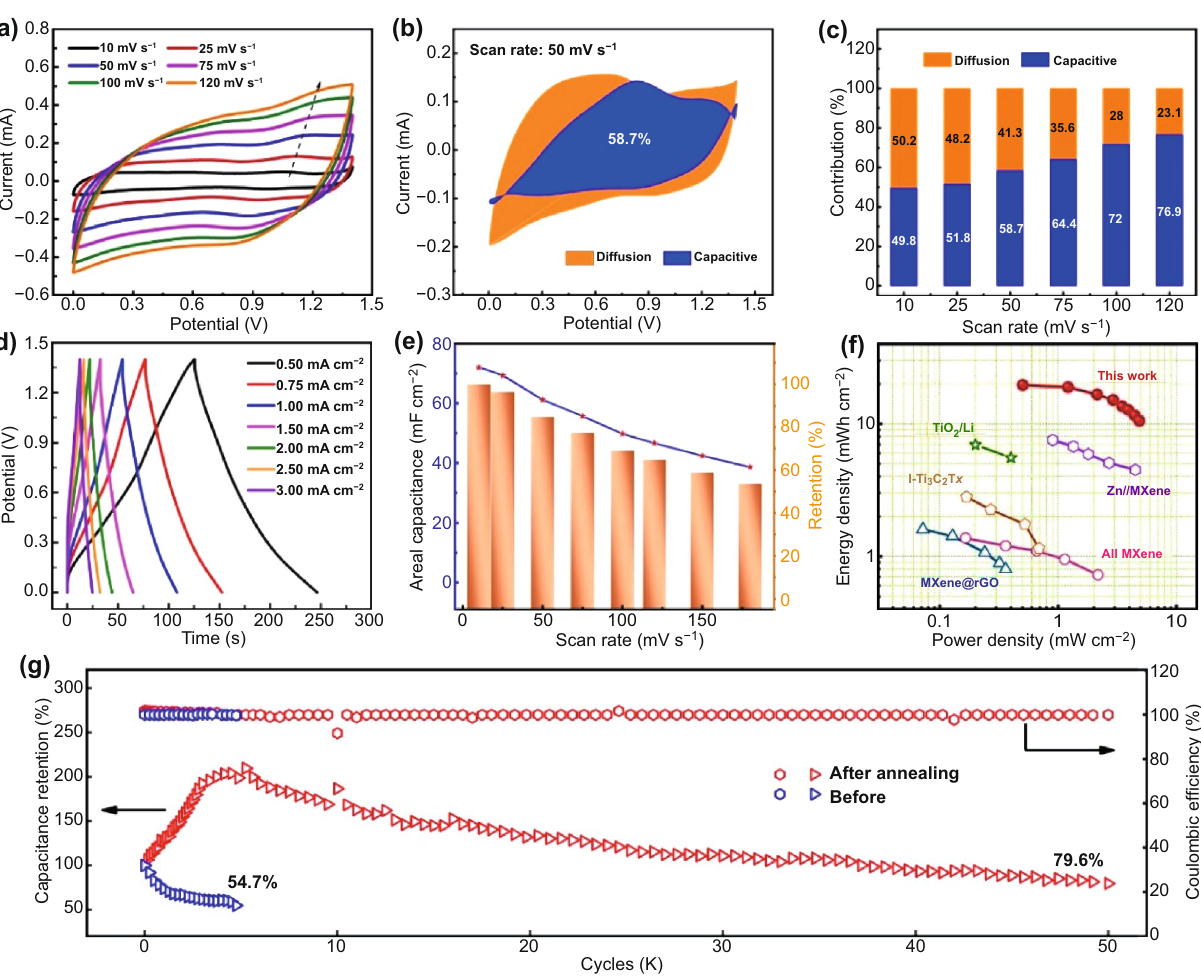
Fig. 3 Electrochemical performances of the Ti 3 C 2 T x -based concentric circular Zn-ion MSC. a Cyclic voltammetry (CV) profiles of the fabri- cated MSCs without annealing treatment at different scan rates varying from 10 to 120 mV s −1 . b Capacitive and diffusion current of the in-situ annealed MSCs at a scan rate of 50 mV s −1 . c Capacitive and diffusion contribution ratio of the in-situ annealed MSCs at different scan rates. d Galvanostatic charge–discharge (GCD) curves of the in-situ annealed MSCs at different current density (0.5–3.0 mA cm −2 ). e Variation of areal capacitance with various scan rates. f Ragone plot of areal energy density vs. power density for the fabricated in-situ annealed MSC in compari- son with the reported Zn-ion devices. g Cycling stability of the fabricated